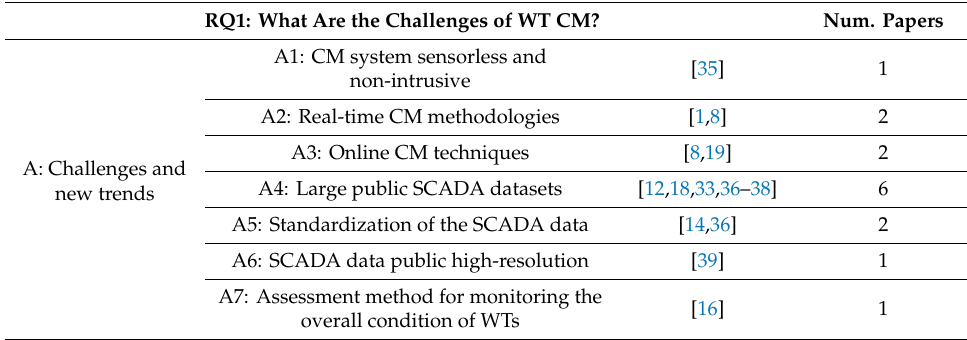
Table 5. Articles on challenges in the condition monitoring (CM) of WTs.